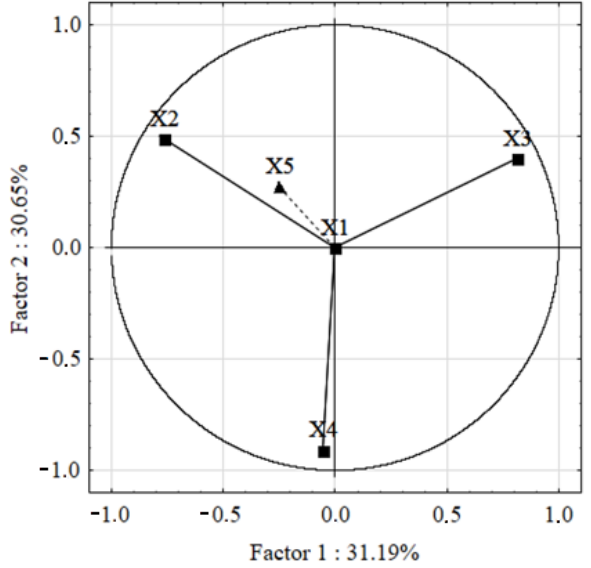
Figure 6. Biplot graph with projections of the loadings of the main components PC1 and PC2.